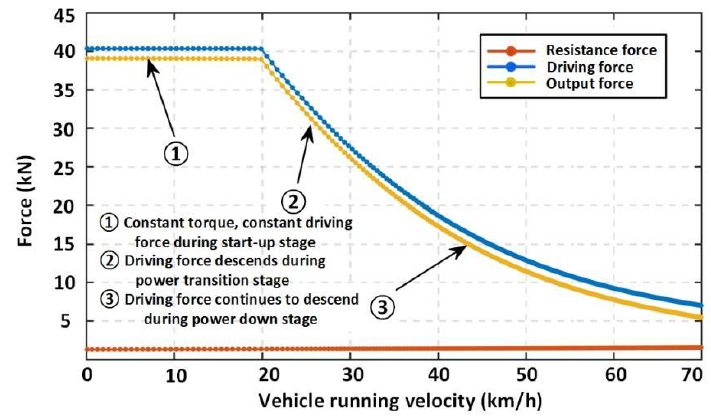
Through the slope of the line between each power curve and the origin (green dotted line) in Figure 10, the changing trend of each part of the force can be obtained. In the constant torque starting stage (0~19.72 km/h), the driving power of the power system has a linear relationship with the velocity, and the driving force should be a fixed value. In the power transition stage (19.72~27.06 km/h), the driving power is still increasing, but the slope of the connecting line between the driving power and the origin begins to decrease, so the driving force gradually decreases. In the power drop stage (above 27.06 km/h), the driving power gradually decreases, and the driving force continues to decrease. The driving resistance refers to the sum of all resistances except acceleration resistance. In this process, the driving resistance always increases slowly with the increase of velocity. The above results are verified by combining the driving force-resistance balance diagram obtained from the simulation of the dynamic load model of the dynamic system, as shown in Figure 11.